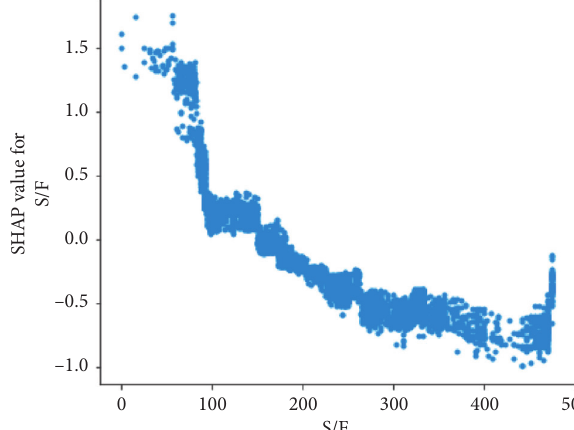
Figure 6: S/F partial dependence plot. The y -axis reflects the probability of death as a positive value denotes a higher probability. The x -axis demonstrates the S/F value. As S/F decreases, the probability of death increases. The probability of death appears to rise significantly below an S/F value of 150. S/F :SaO 2 /FiO 2